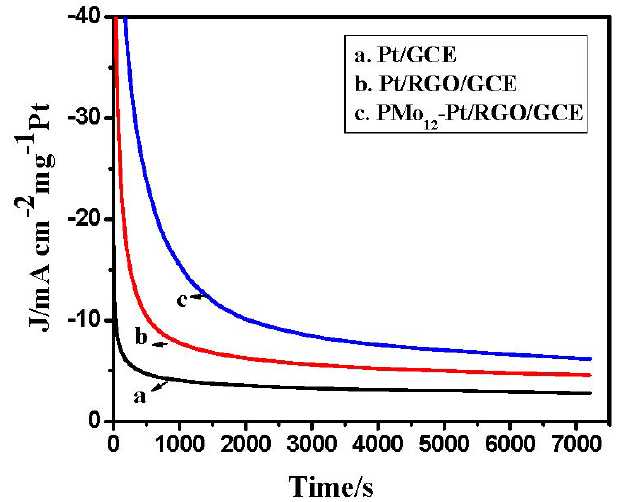
Figure 8. Chronoamperometric curves of different modified electrodes: ( a ) Pt/GCE; ( b ) Pt/rGO/GCE; ( c ) PMo 12 -Pt/rGO/GCE in 0.5 M H 2 SO 4 + 1 M CH 3 OH solution at a fixed potential of 0.68 V for 2 h.